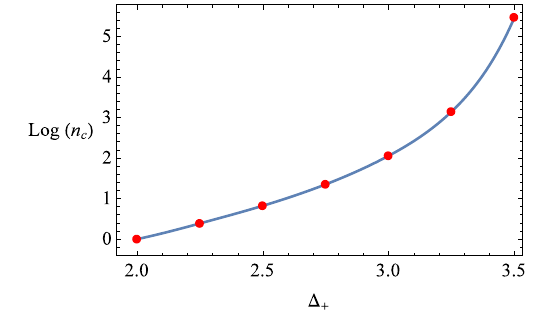
Fig. 5 The logarithm of the critical Rényi parameter as a function of (cid:16)